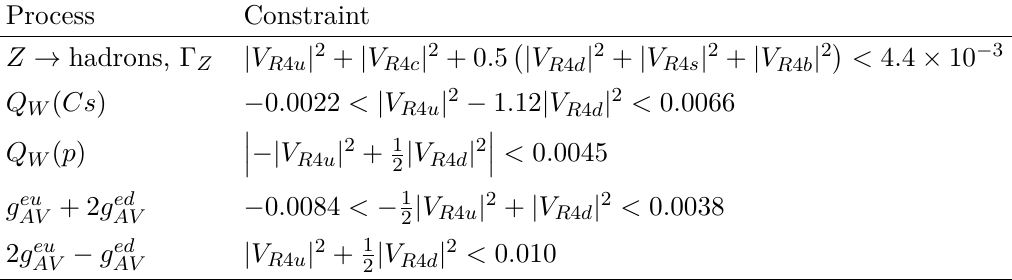
Table 8 . Limits on the mixing of the first three families with an extra vector-like isodoublet from low energy electroweak observables and Z physics. For details see the